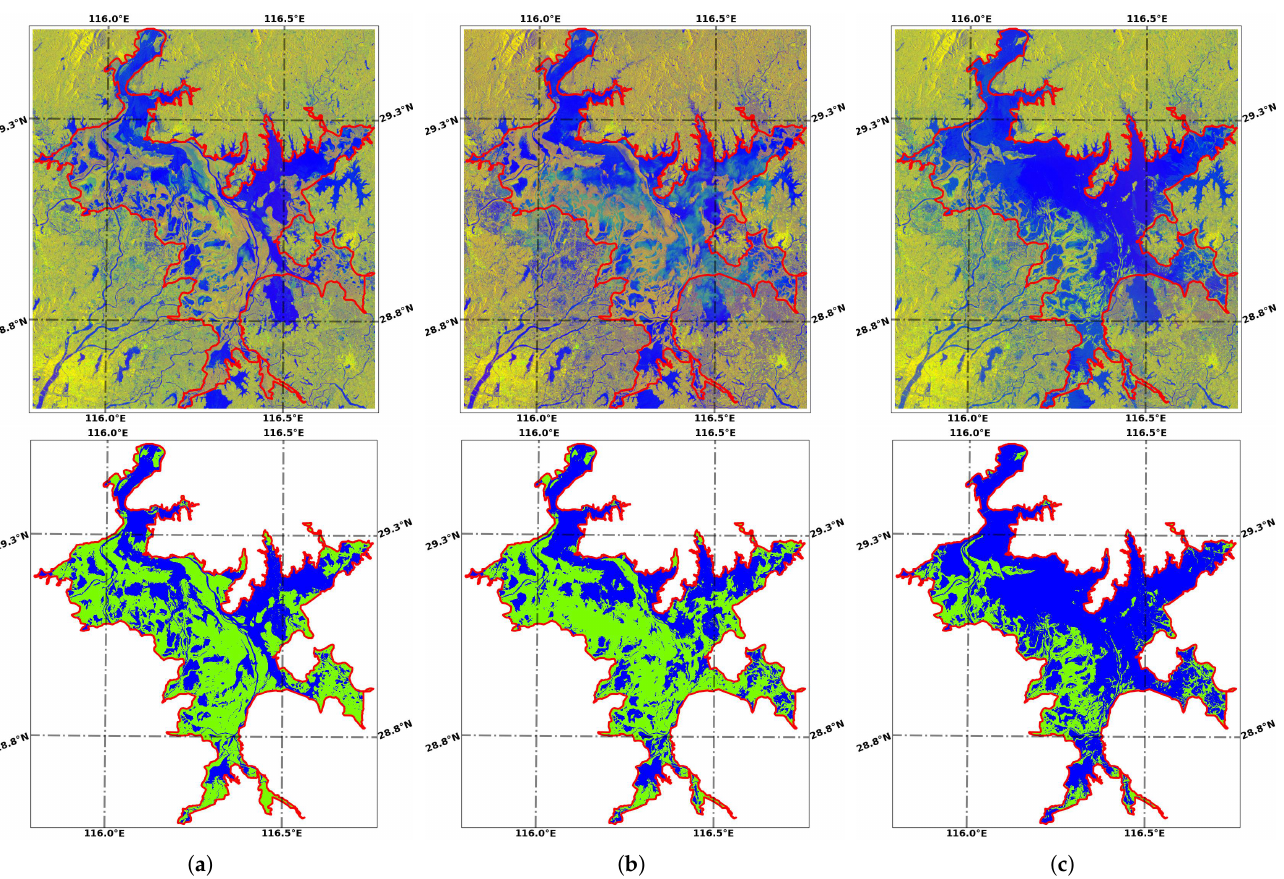
Figure 18. The influences of floats and sediments on water extraction. The upper figures are for the Sentinel-1 SAR data displayed in VH/VV/(VH + VV) and the lower figures are for the classification results, with blue for water and green for non-water. ( a ) 27 May 2020, water level of 14.6 m; ( b ) 2 June 2020, water level of 16.0 m; ( c ) 8 June 2020, water level of 16.9